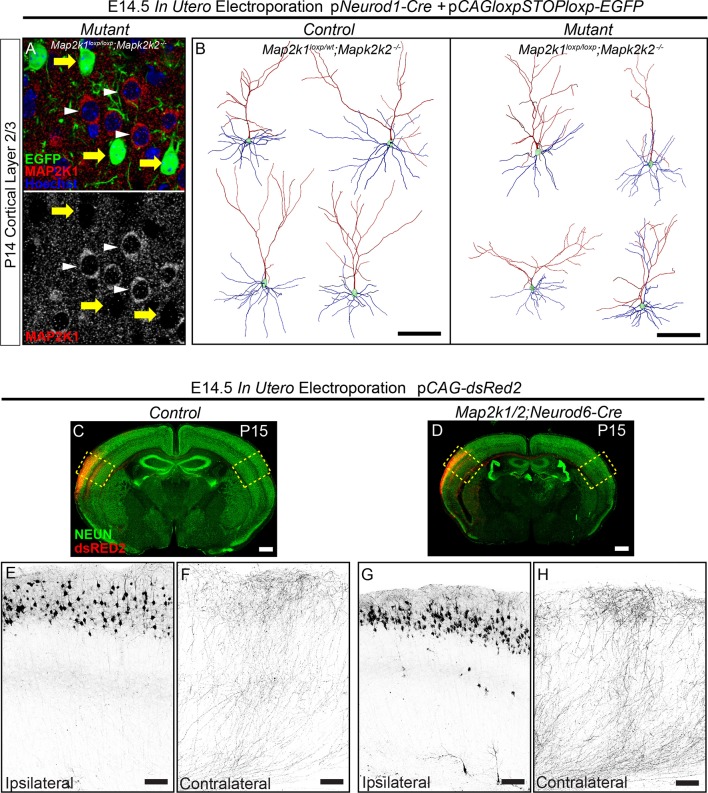
ERK/MAPK signaling is dispensable for the differentiation and axonal morphology of callosal projection neurons in layer 2/3.(A–B) Co-in utero electroporation (IUEP) of pNeurod1-Cre and ploxp-STOP-loxp-EGFP plasmids into E14.5 control (Map2k1loxp/wt;Map2k2-/-) and mutant (Map2k1loxp/loxp;Map2k2-/-) embryonic ventricles results in layer 2/3 neuron autonomous Map2k1/2 deletion and fluorescent labeling of excitatory neuron dendrites and axons. A. Immunohistochemical detection of MAP2K1 and EGFP expression in cortical layer 2/3 neurons of P14 Map2k1loxp/loxp;Map2k2-/-mice that were electroporated at E14.5 with pNeurod1-Cre and ploxp-STOP-loxpEGFP plasmids. Note the substantial loss of MAP2K1 expression in EGFP labeled mutant pyramidal neurons (yellow arrows) when compared to unlabeled control excitatory neurons (white arrowheads). (B) Representative neurolucida reconstructions of layer 2/3 neurons from P14 control (Map2k1loxp/wt;Map2k2-/-) and mutant (Map2k1loxp/loxp;Map2k2-/-) cortex following electroporation with pNeuroD-Cre and ploxp-STOP-loxpEGFP at E14.5 (scale bar=100 µm). (C–I) IUEP of pCAG-dsRed2 into E14.5 control and Map2k1/2;Neurod6-Cre mutant embryos leads to fluorescent labeling of layer 2/3 cortical neurons and callosal axons. P15 forebrain sections from control (C) and Map2k1/2;Neurod6-Cre mutant (D, scale bar=2 mm) mice were immunostained for NEUN and dsRED2. High resolution confocal images show that upper layer neurons were electroporated at similar efficiency in control (E) and mutant (G) forebrains and contralateral axon innervation is not different (F, H, scale bar = 50 µm).